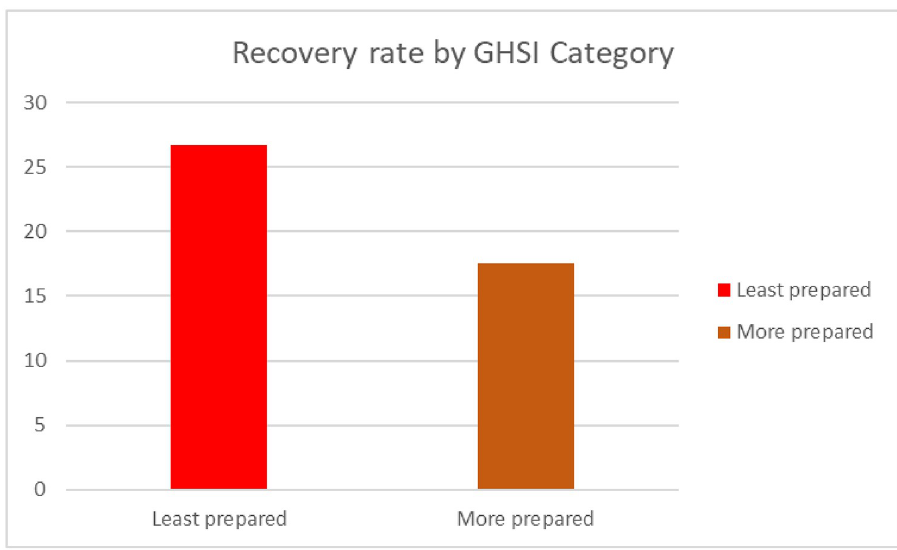
Fig 9. Recovery rate by GHSI